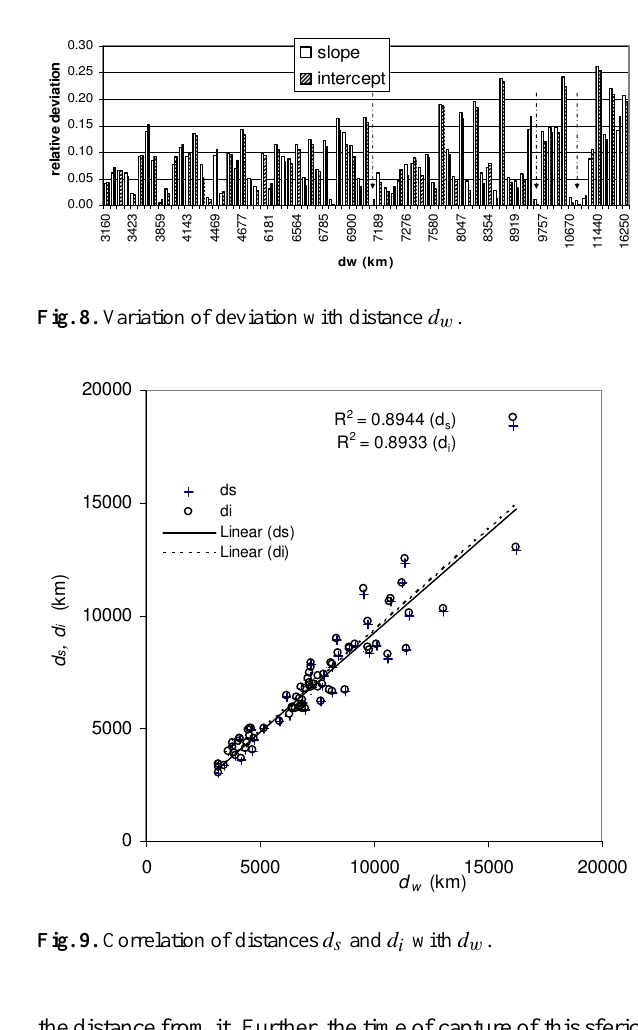
Figure 8 Variation of deviation with distance d w .